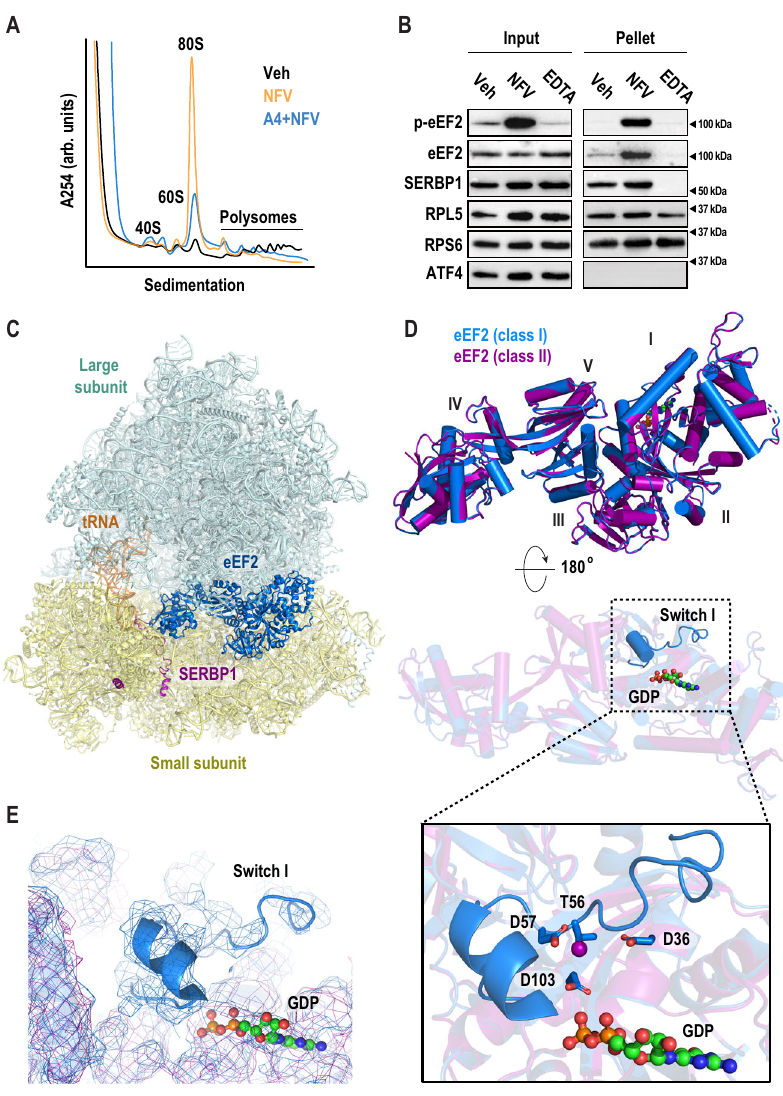
Fig. 5 Nel fi navir treatment inactivates ribosomes via eEF2. A Representative polysome pro fi les following treatment with vehicle (black) or nel fi navir (red). F11 cells were treated with either vehicle (Veh) or nel fi navir (NFV) for 1 h, followed by 5 min of cycloheximide (CHX, 100 µ g/ml). Cells were lysed and used to generate polysome pro fi les. B Representative immunoblots from three biological replicates of ribosomes puri fi ed by sucrose cushion (cropped to depict one representative band per condition). F11 cells were treated with either vehicle (Veh) or nel fi navir (NFV) for 1 h, followed 100 µ M emetine for 5 min. Cells were lysed and loaded on 30% sucrose cushions before ultracentrifugation to pellet ribosomes. An additional vehicle sample was further treated with EDTA (30 µ M) to dissociate polysomes prior to loading on sucrose cushion. Immunoblots were performed using input and resuspended ribosome pellets. C Cryo-EM structure of eEF2-bound 80S mouse ribosome in the rotated state. The large subunit (LSU) is shown in pale cyan, the small subunit in pale yellow (SSU), eEF2 in marine, SERBP1 in purple, and E-site tRNA in orange. D Overlay of eEF2 (marine) and p-eEF2 (purple) structures shows nearly identical conformations (RMSD 0.256 Å 2 for corresponding C alpha atoms). The two structures differ in the presence of an ordered switch I in the unphosphorylated eEF2 (marine) near the bound GDP. E Density of eEF2 (marine) and p-eEF2 shows the presence of switch I in the unphosphorylated eEF2 structure. F eEF2 Thr56, target of eEF2K, is surrounded by negatively charged residues Asp57, Asp36, and Asp103 and is oriented towards the GDP beta-phosphate. This suggests that switch I rearranges upon Thr56-phosphorylation due to electrostatic repulsion. Uncropped blots are presented in Supplemental Fig. PRE-1 state, PDB ID: 6y0g) and class two is in a back-rotated rather than GTP, yet eEF2 is still present in the A site. Based on conformation (4° back-rotation). These conformations are these results, we conclude that nel fi navir treatment induces reminiscent of eEF2-containing TI-POST − 1 and − 2 states 85 , formation of ribosomes containing eEF2 bound to GDP and which represent ribosomes that have not undergone full SERBP1. translocation. During translation, GTP hydrolysis occurs late in the elongation process and is only required for the resolution of late TI-POST states. There it facilitates dissociation of eEF2 and formation of the bona fi de POST-state. As a result, the ribosome is bound to a fully translocated tRNA 2 -mRNA module and the A site is empty. Interestingly, in our classes, eEF2 is bound to GDP,